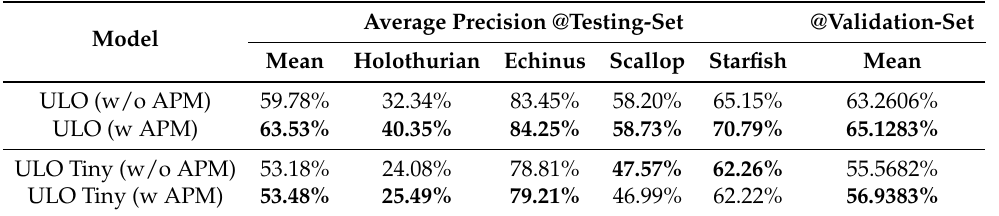
Table 3. Ablation study of the adaptive pre-processing module. Experiments were conducted on ULO and ULO Tiny networks with or without APM, and the results were evaluated by the mAP. The results demonstrate that APM is beneficial in improving performance in both ULO and ULO Tiny. The best results are in bold.